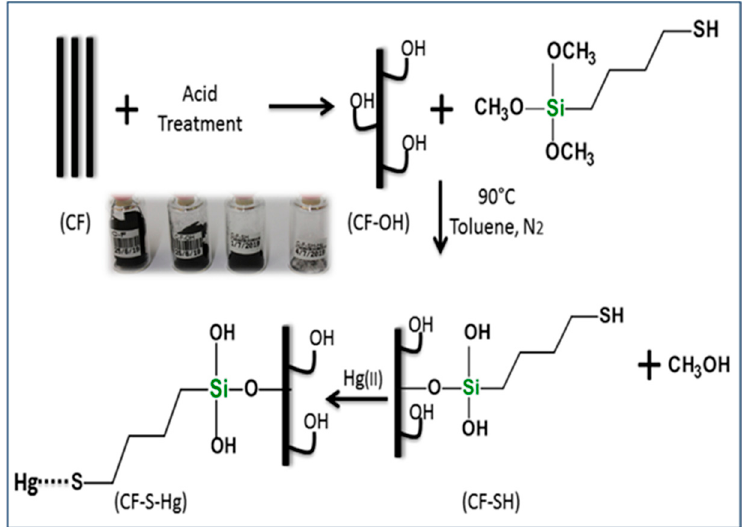
Figure 1. Schematic diagram of modification and functionalisation processes for CF.